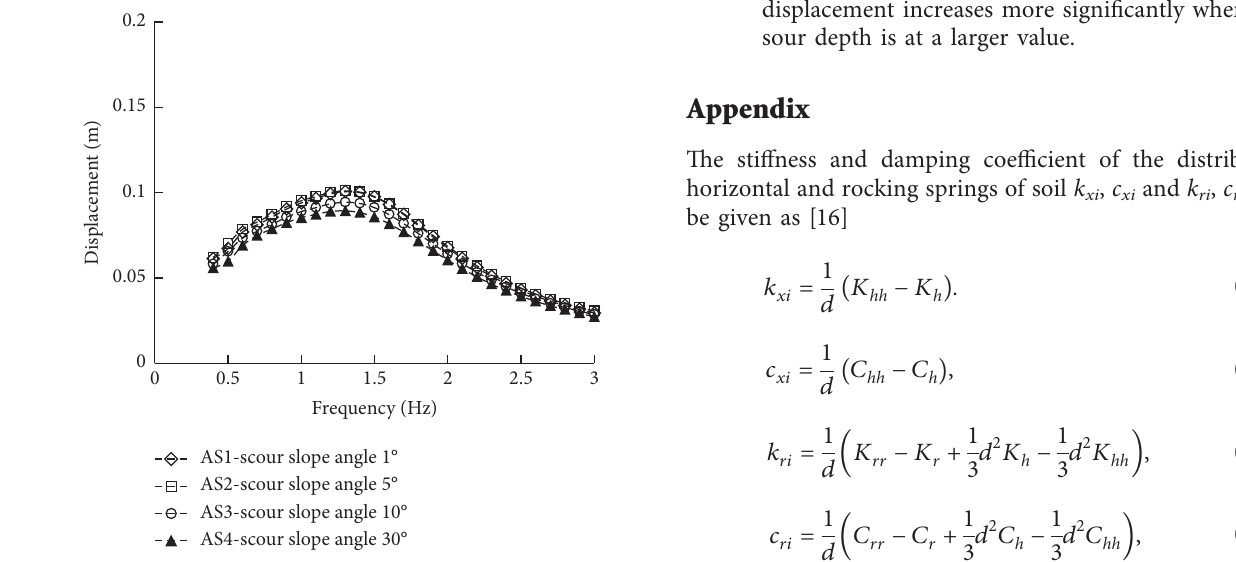
Figure 16: Effect of slope angle on the dynamic response of caisson foundation ( S d � 0.15 d ).